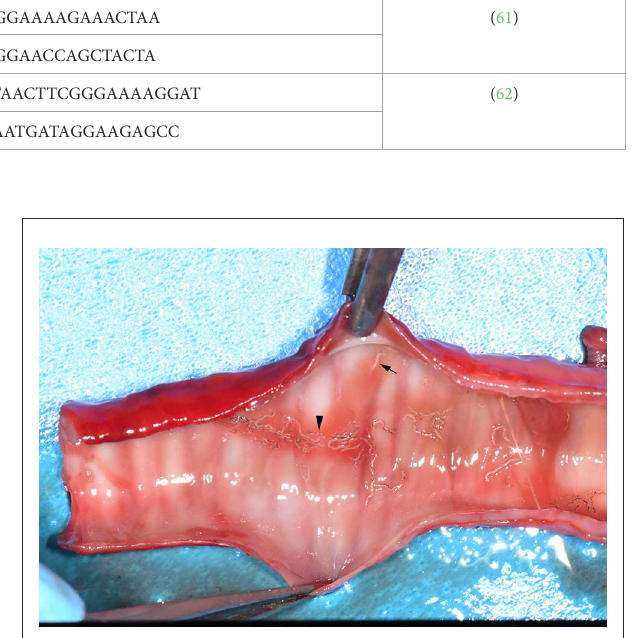
FIGURE1 Adult nematodes of C. petrowi in the trachea of a badger collected in Borod locality. Arrow head: Female nematodes with a thin, black tube inside; Black arrow: Male nematodes, smaller and white.